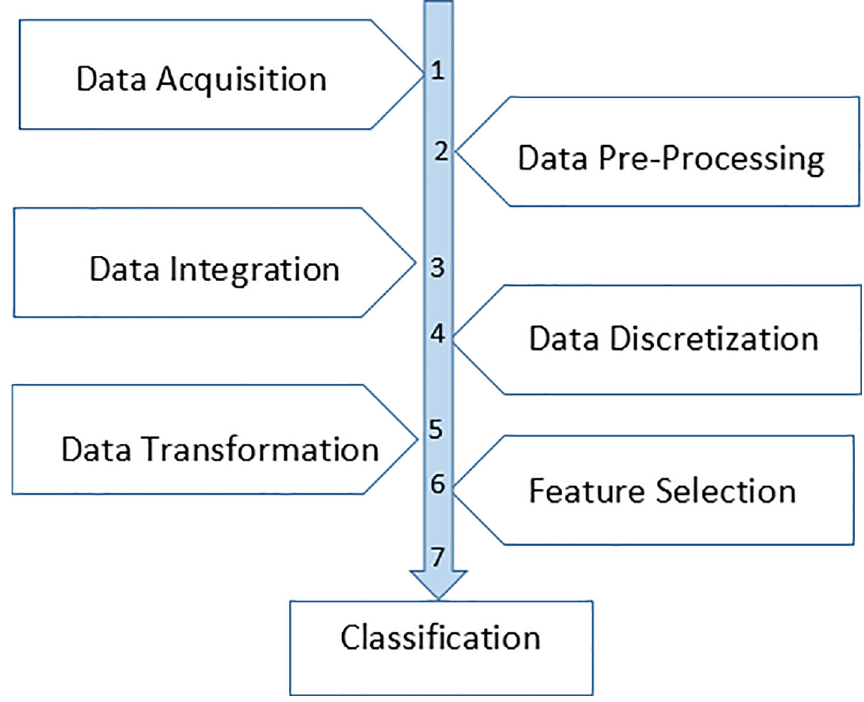
Figure 1. Flow of the